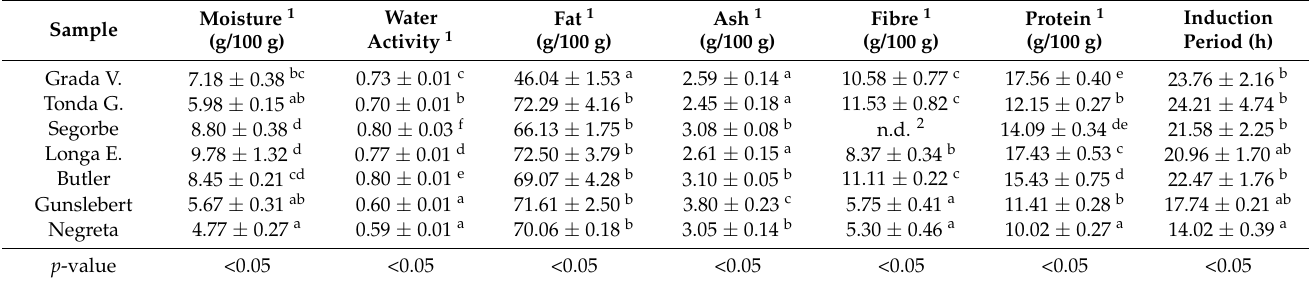
Table 6. Hazelnuts’ chemical properties (mean ± standard deviation as determined for the